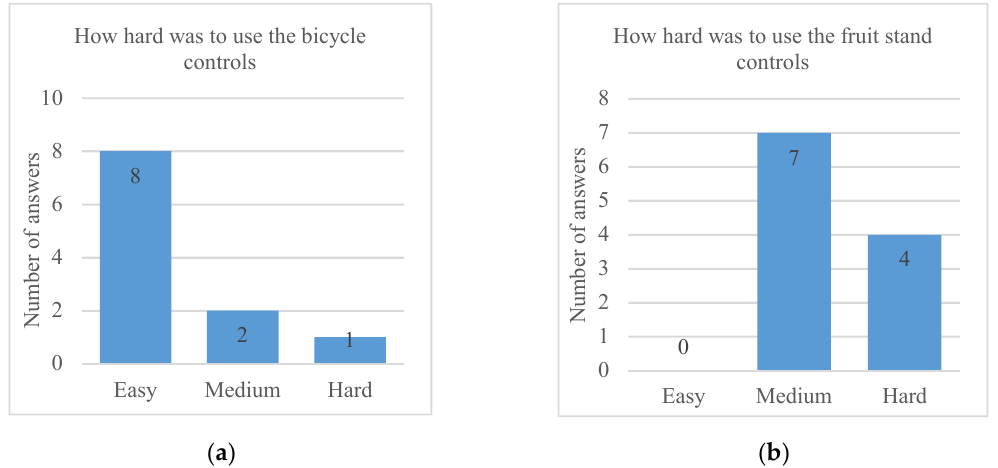
Figure 3. ( a ) Results of questionnaire regarding bicycle controls; ( b ) Results of questionnaire on fruit stand controls. Table 1. Results of the simulation sickness questionnaire.